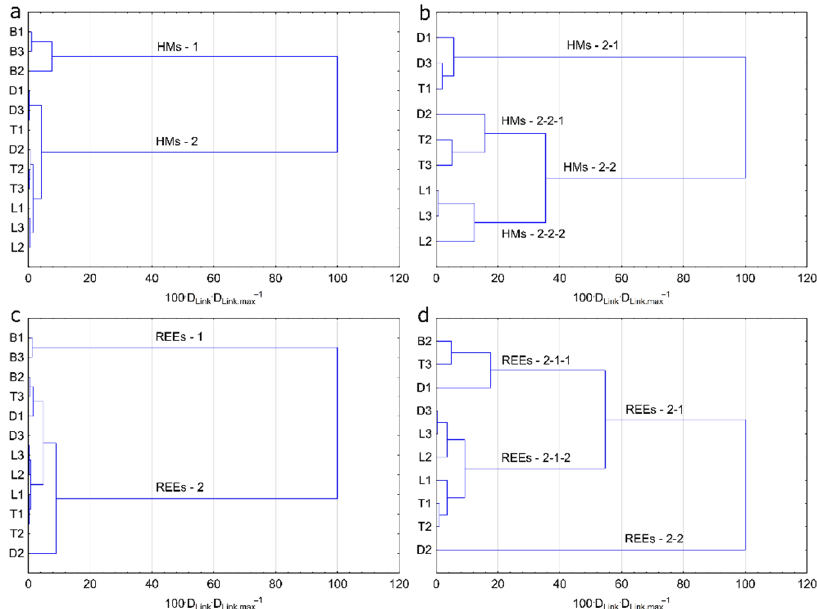
Figure 5. Division of study sites in terms of HM and REE content into: ( a , c ) groups and ( b , d ) sub- groups.